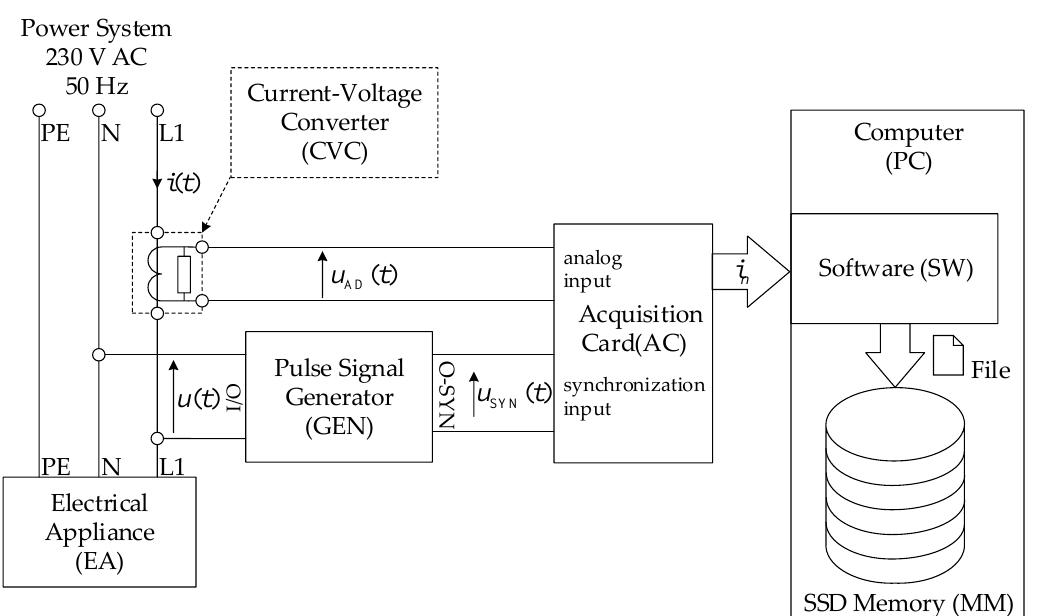
Figure 4. Diagram of the measuring system of the HF-GEN method.